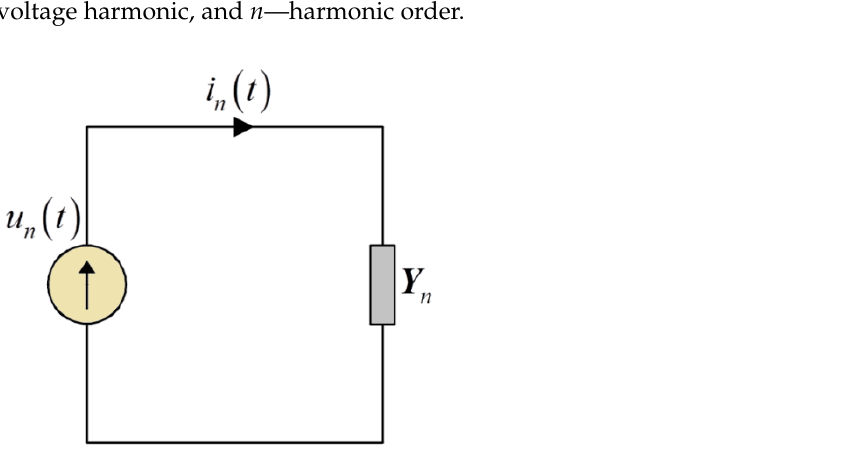
Figure 1. Scheme of a single-phase system supplied from a nonsinusoidal voltage